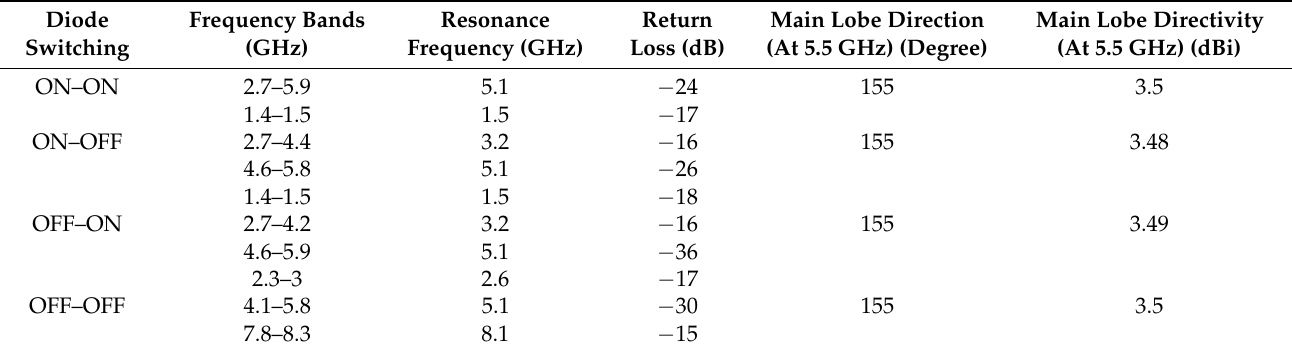
Table 2. Results for frequency-reconfigurable antenna.